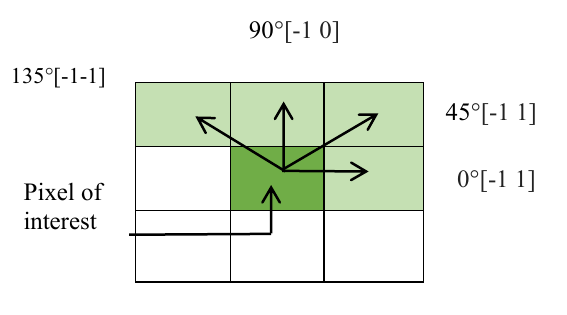
Figure 1. Gray Level Co-occurrence Matrix Angle